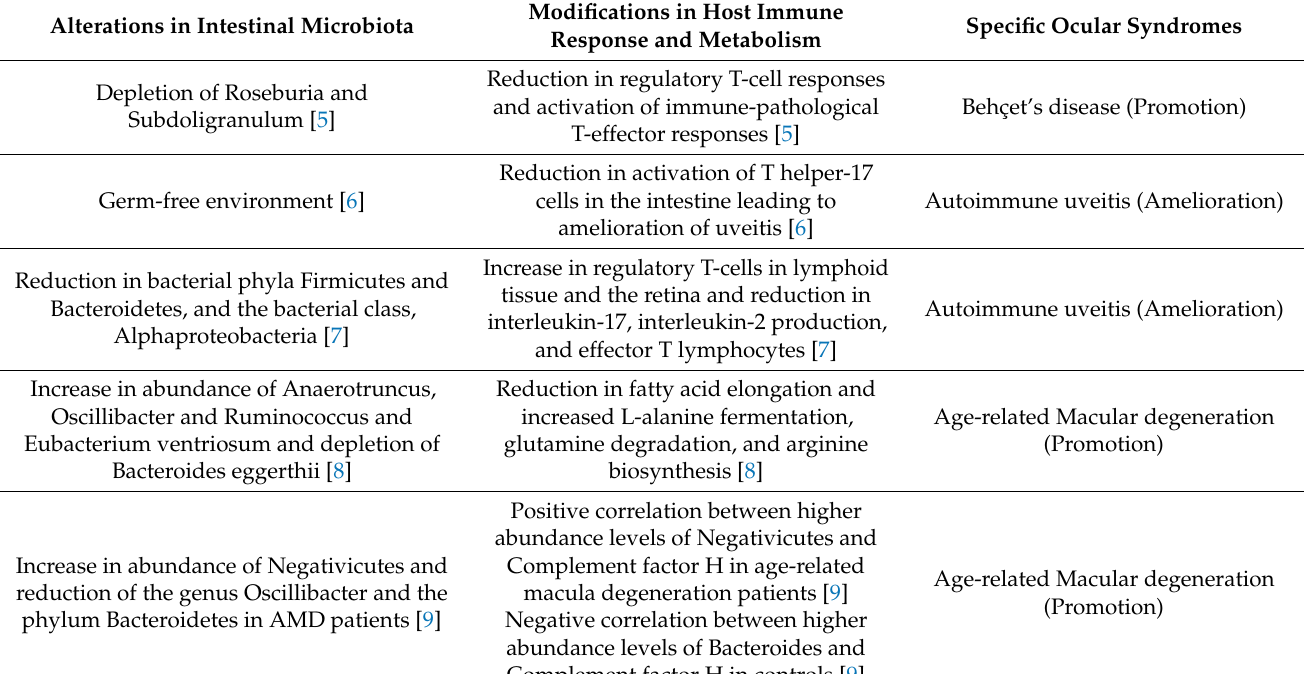
Table 1. The association between alterations in intestinal microbiome and the immunopathogenesis of specific ocular